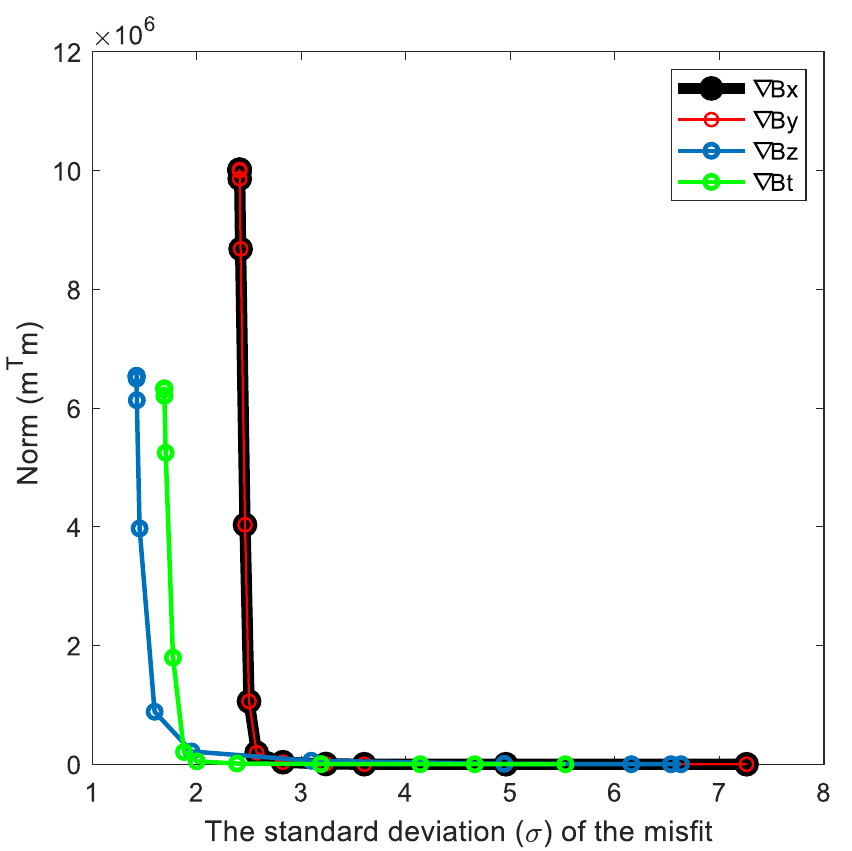
Figure 2. The trade-off curve of the north–south ∇ B x , ∇ B y , ∇ B z , and ∇ B t . The variation of the norm ( m T m) with respect to the standard deviation ( σ ) of the misfit shows that the knee of the curve is located at the damping parameter, equaling 10 − 4 .